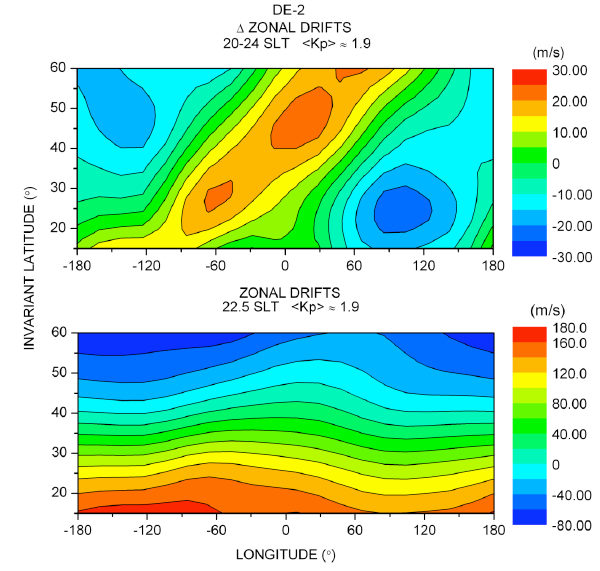
Fig. 5. Longitudinal and latitudinal dependence of average quiet- time relative zonal plasma drifts in the early night sector. Figure 6 Fig. 6. Latitudinal and longitudinal dependence of relative zonal